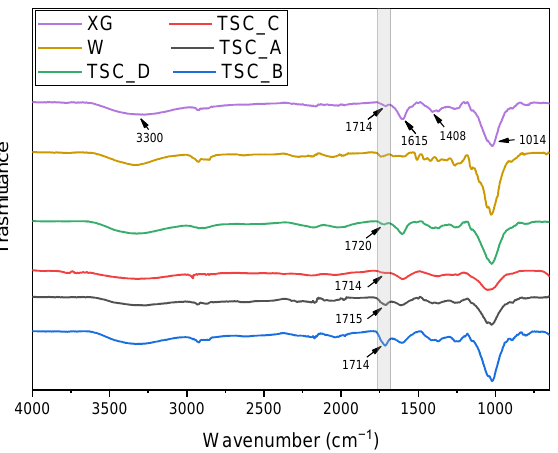
Figure 2. FT-IR analysis on the TSC composites and neat materials.